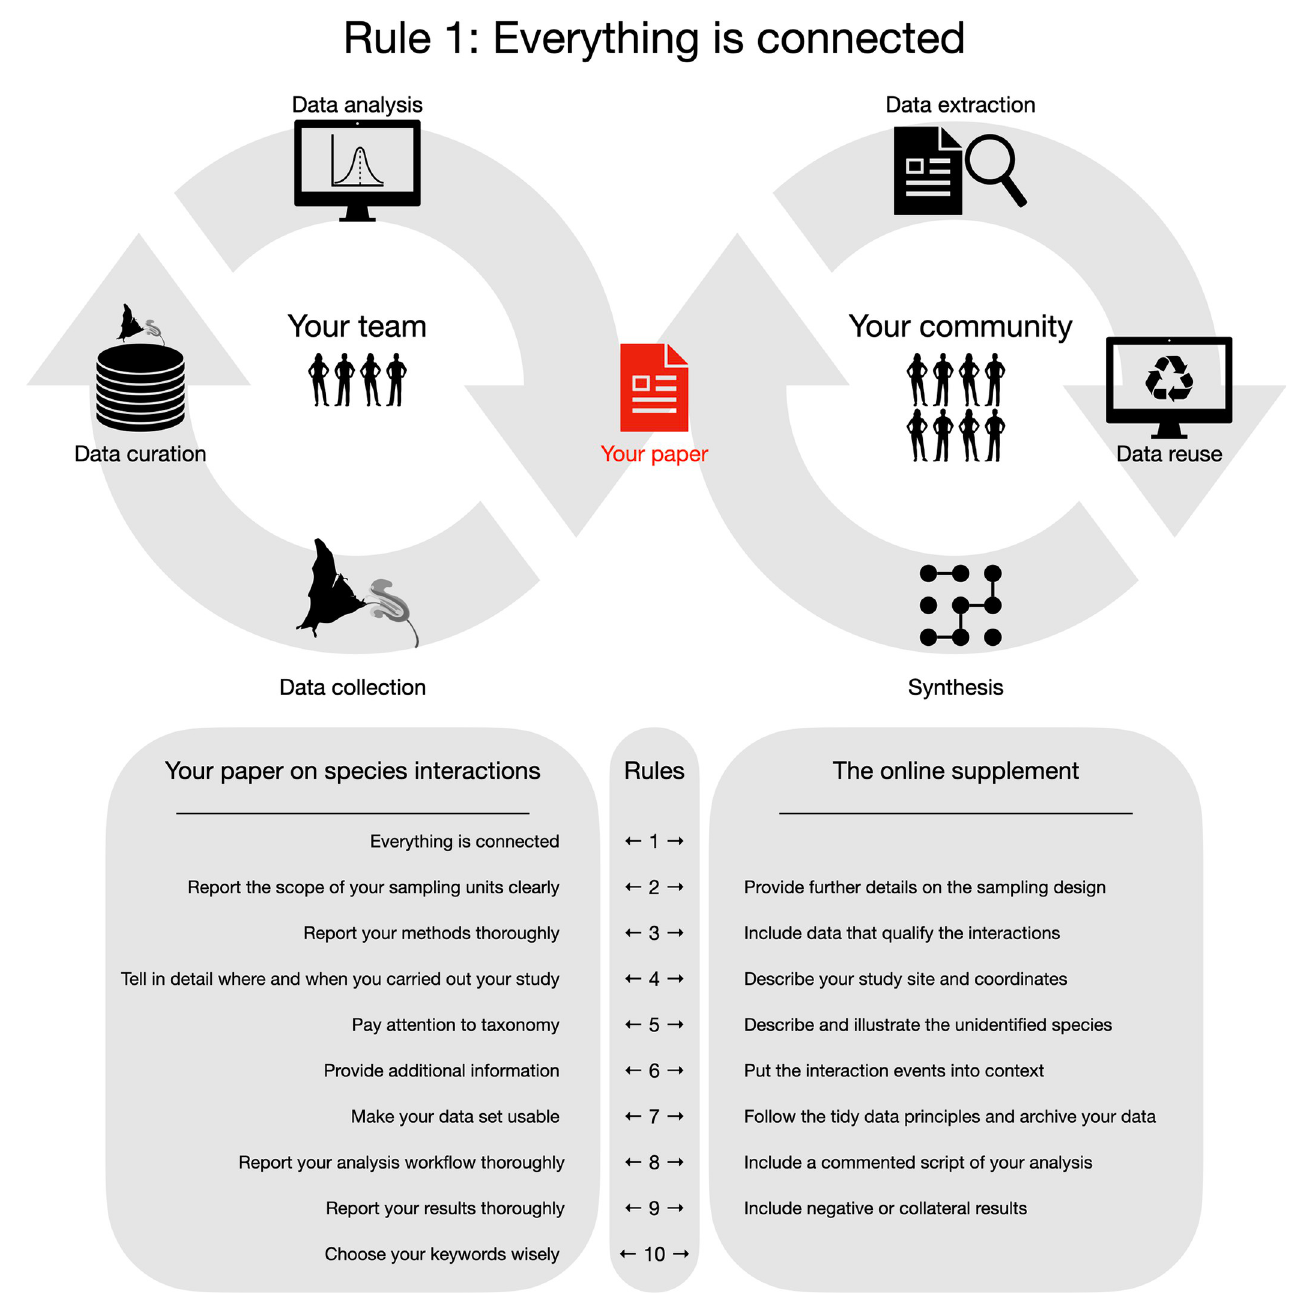
Fig 1. Our 10 simple rules are connected to one another. Follow them and use our roadmap when designing and publishing your study on species interactions. This additional work might boost your study’s impact and usability, thus helping your community and your team. Efficient communication goes a long